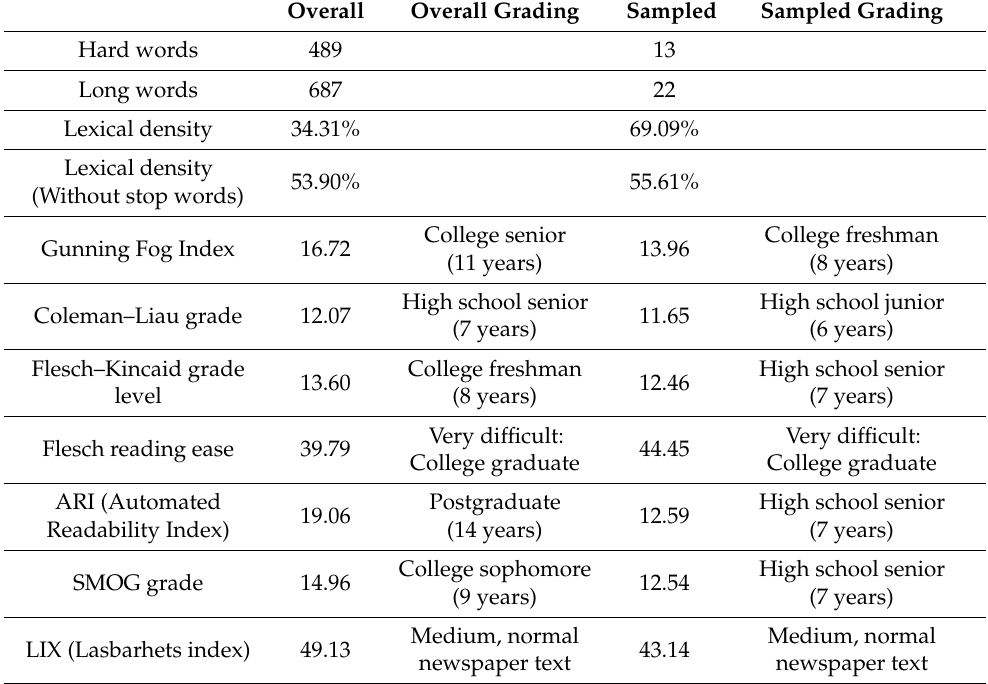
Table 5. Readability for Blog (Source: Advanced Text Analyzer).